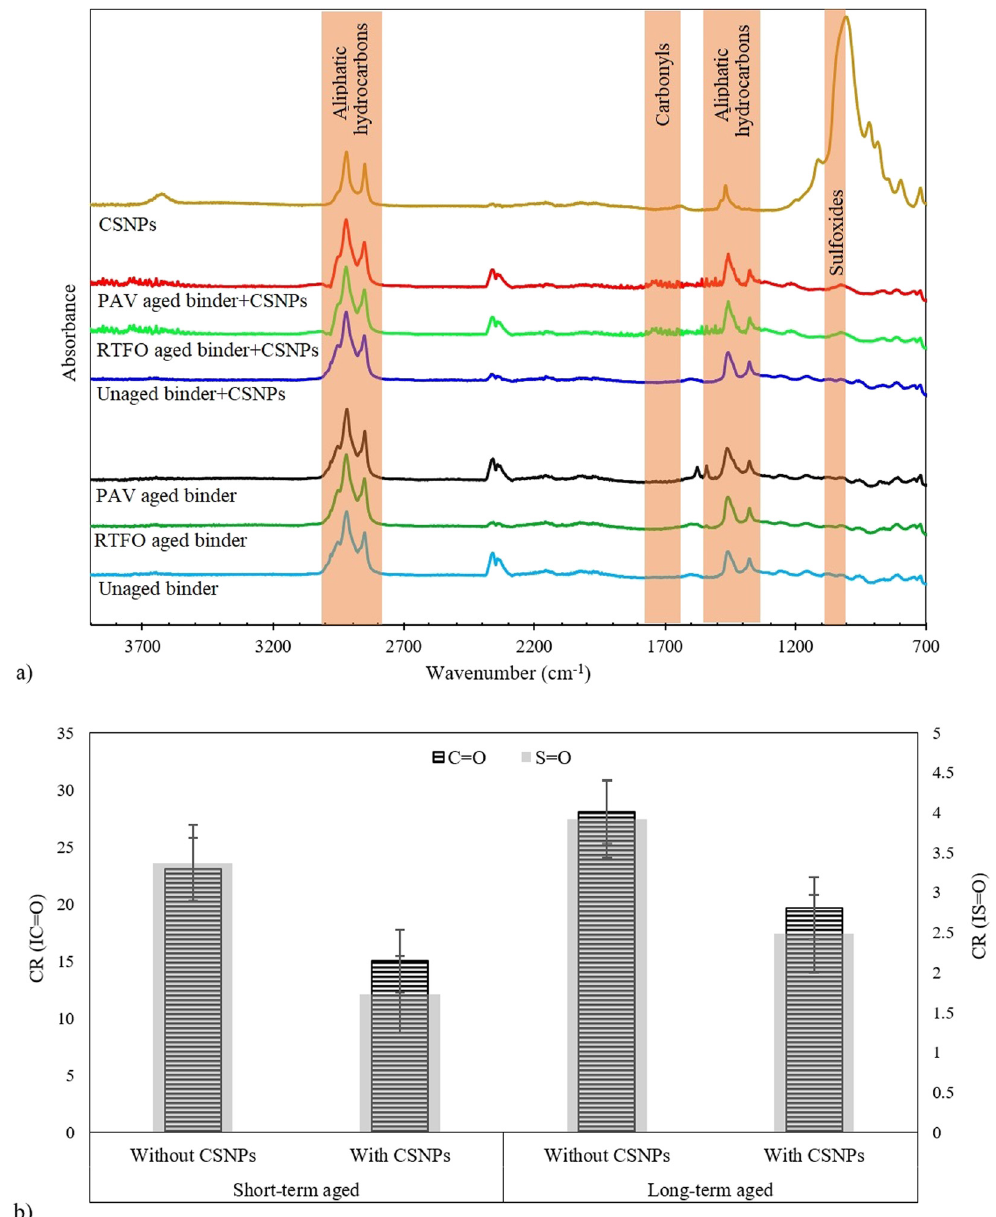
Figure 9: ( a ) FTIR spectra of asphalt binders at di ff erent aging conditions ( wavenumber 700 – 4,000/cm ) and ( b ) sulfoxide and carbonyl aging indexes at di ff erent aged